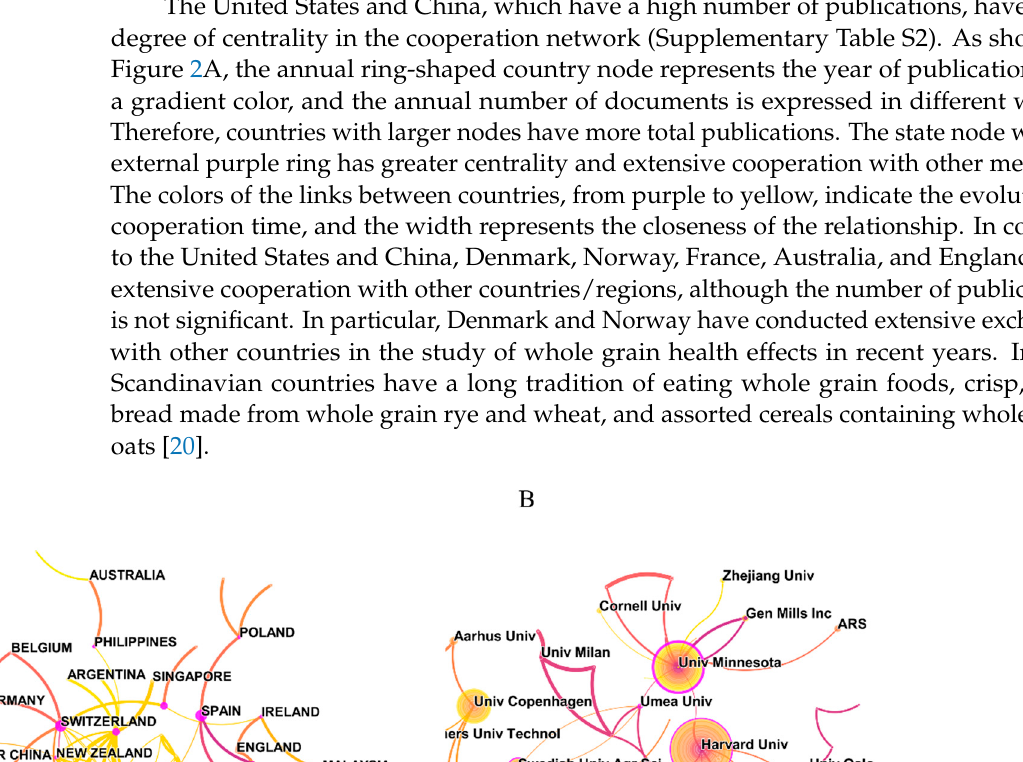
Figure 1. Evolution of publications and contributions of different countries/regions. ( A ) Annual changes in the number of publications. ( B ) Number of publications, without self-citations (actual value/60), H-index (actual value × 10). ( C ) Regional clustering characteristics of publications.